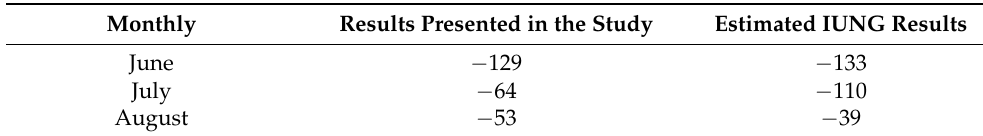
Table 5. Comparison of climatic water balance (CWB) values (mm) estimated from IUNG studies and those obtained in this study. Monthly Results Presented in the Study Estimated IUNG Results June − 129 − 133 July − 64 − 110 August − 53 −